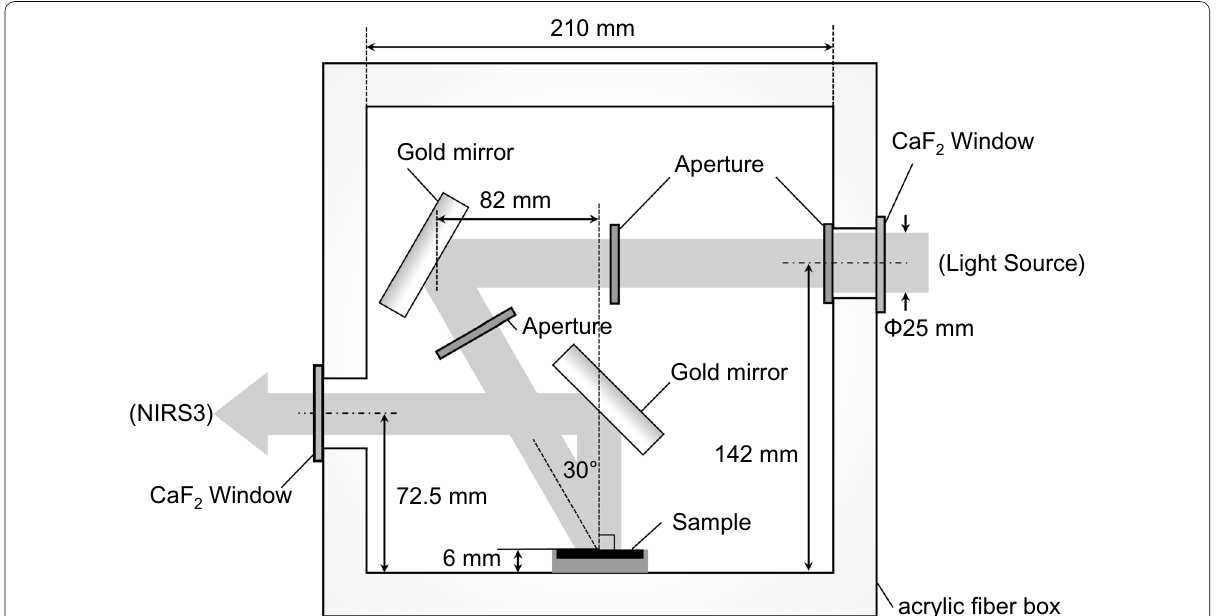
Fig. 1 Schematic diagram of the sample chamber for spectral